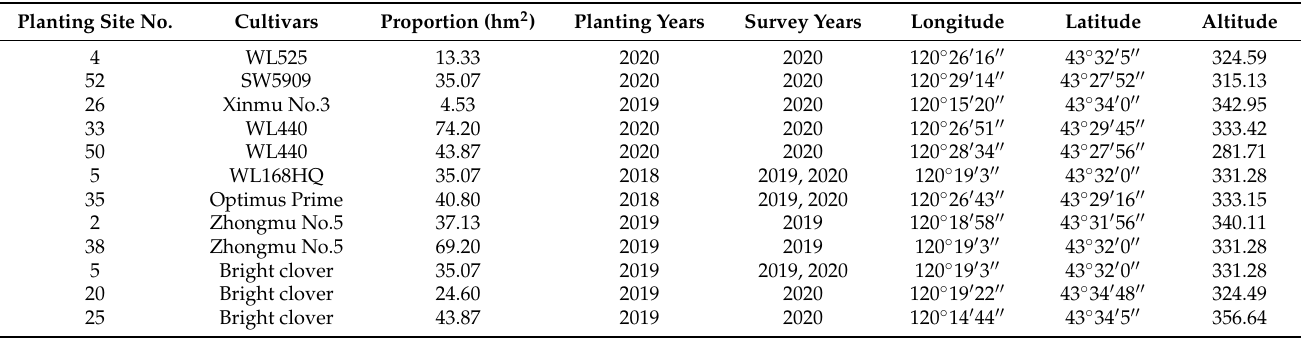
Table 1. Field cultivars and survey